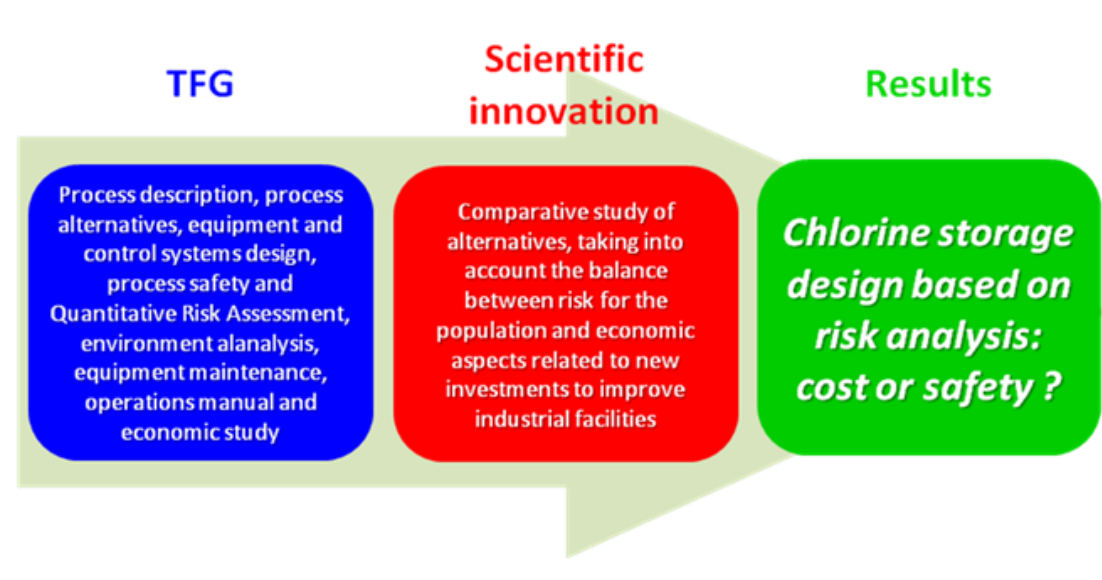
Figure 4. Dynamics and results of the transition between a TFG and a research and scientific innovation